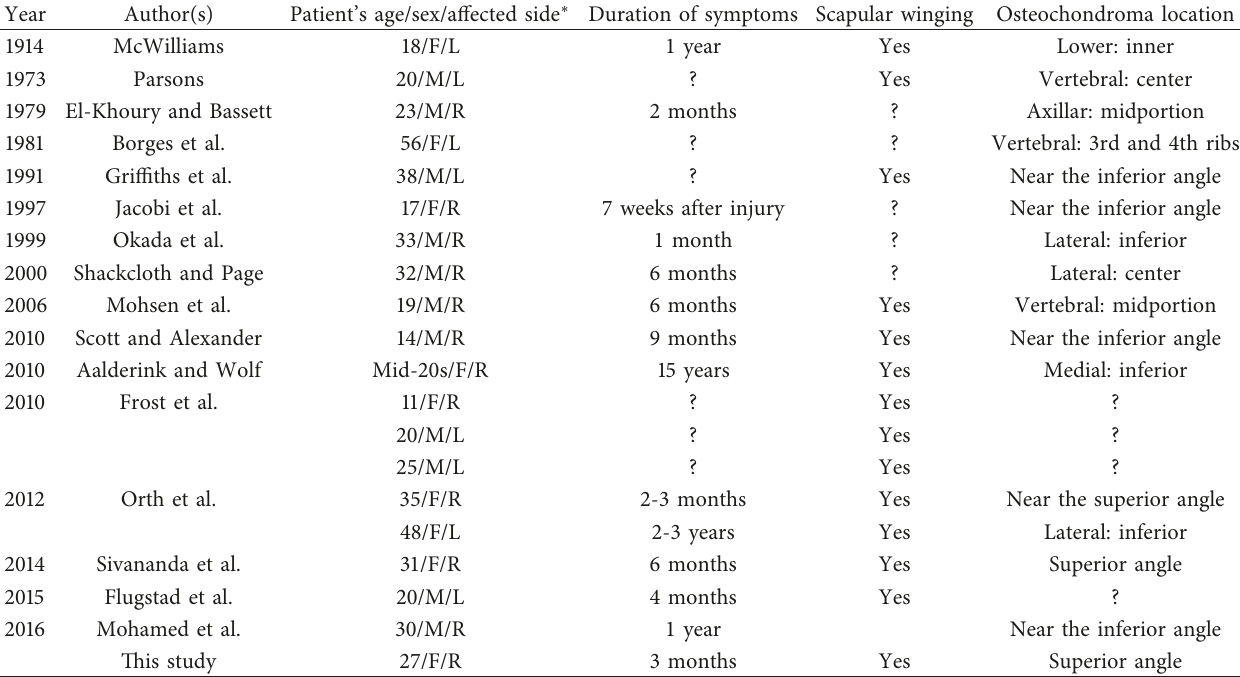
Table 1: Reported cases of solitary ventral-side scapular osteochondroma associated with a large